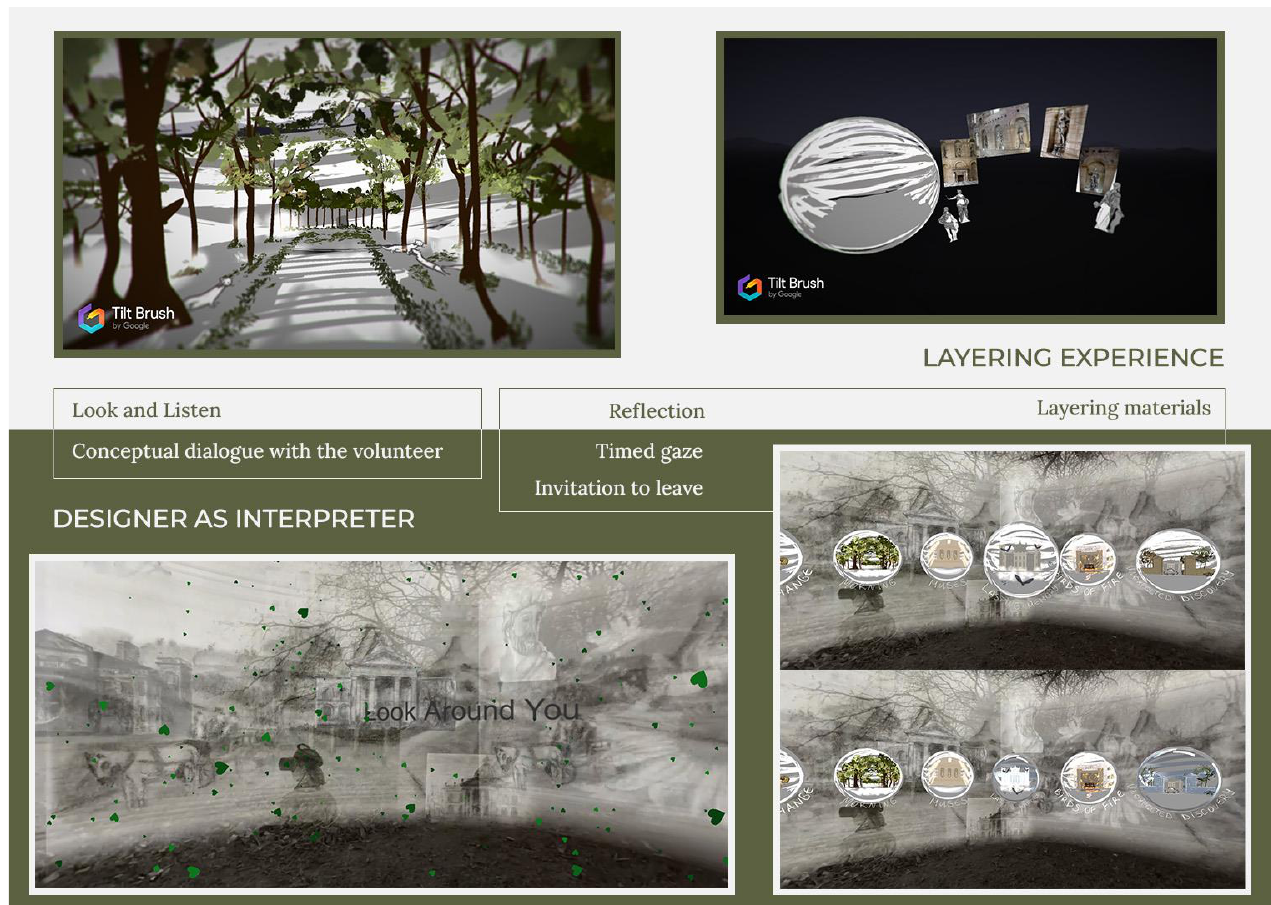
Figure 8. SDH Palimpsest Design Domains and Interaction Qualities. The artwork painted in Tilt Brush is presented here under Tilt Brush standard license and is courtesy of Violeta Tsenova as the artist.